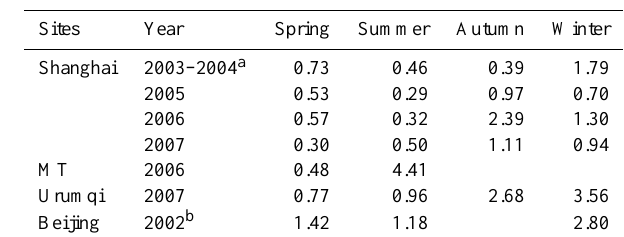
Table 8. Concentrations of K + in PM 2 . 5 at different sampling sites.